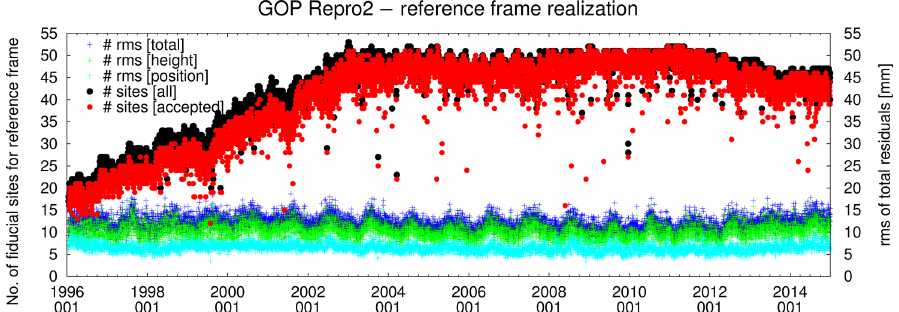
Figure 7. Statistics of the daily reference system realization: (a) RMS of residuals at fiducial stations (representing the total, height and position); (b) number of stations (all and accepted after an iterative